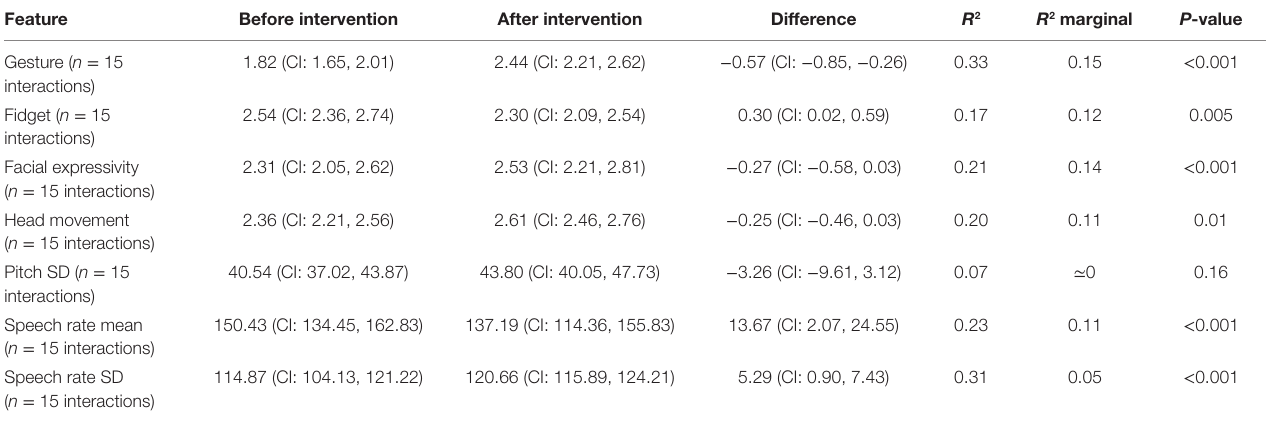
TaBle 4 | Main effect of before vs. after intervention on individual behaviors. Feature Before intervention after intervention Difference R 2 R 2 marginal